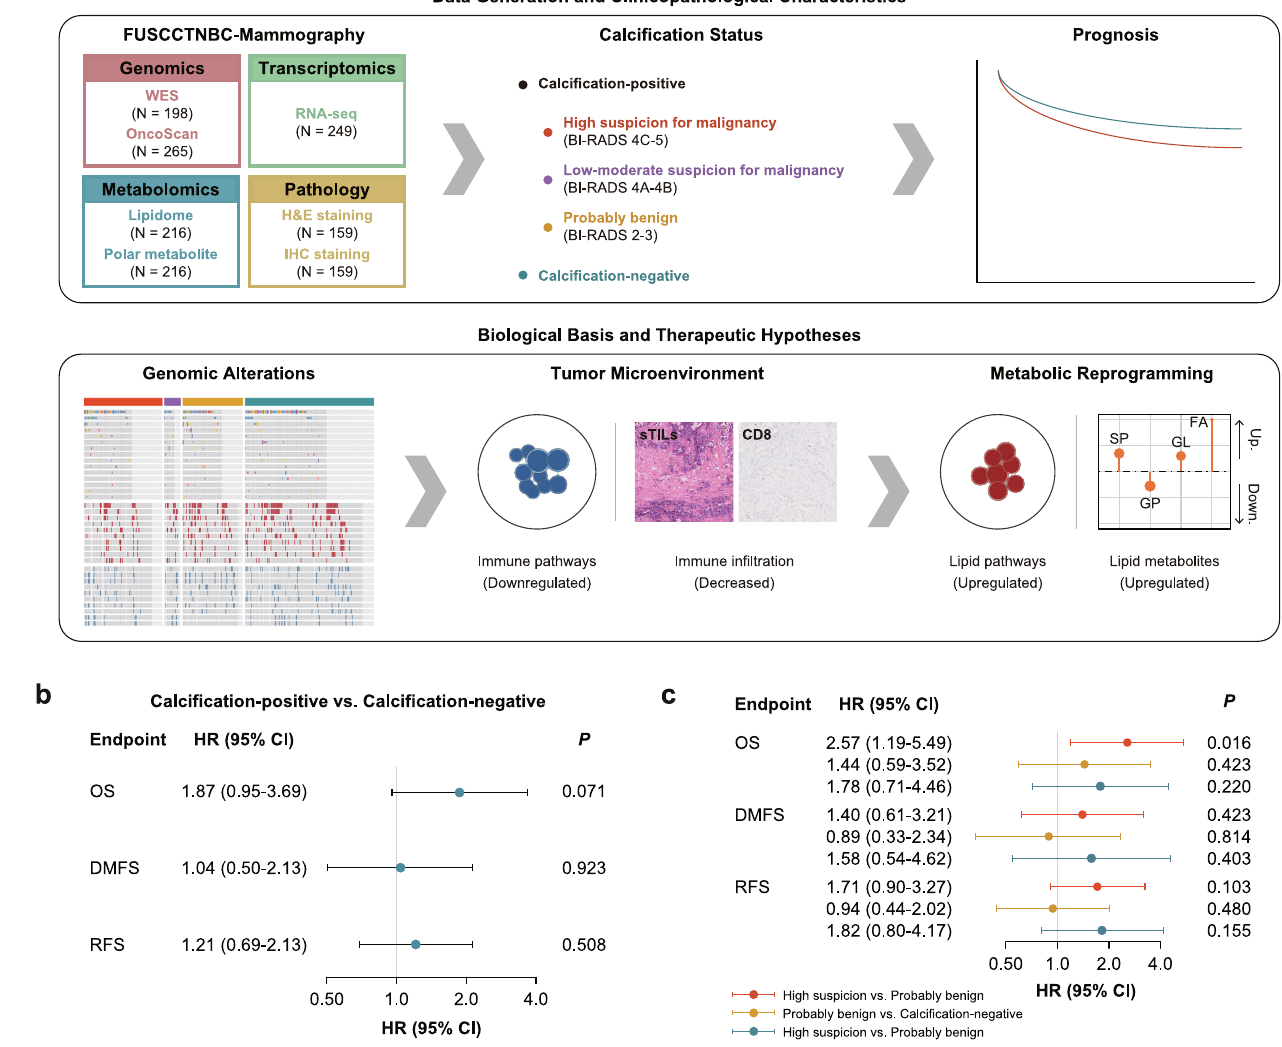
Fig. 1 Schematic overview of the study design. a Omics platforms and analysis work fl ow of the study. b Prognostic value of mammographic calci fi cations. c Prognostic value of calci fi cation of high suspicion for malignancy. Error bars represent con fi dence intervals of the corresponding hazard ratios for different clinical outcomes. Cox regression models were used to estimate the hazard ratios and corresponding con fi dence